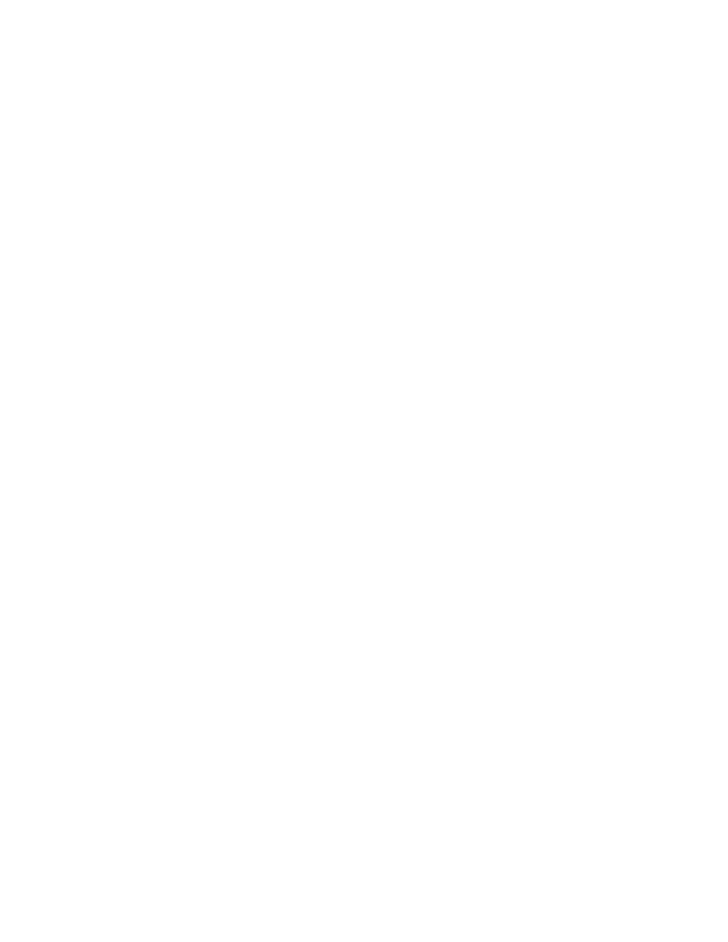
BCC. Aggregates of basaloid epithelial cells with peripheral palisading and central necrosis 200x.